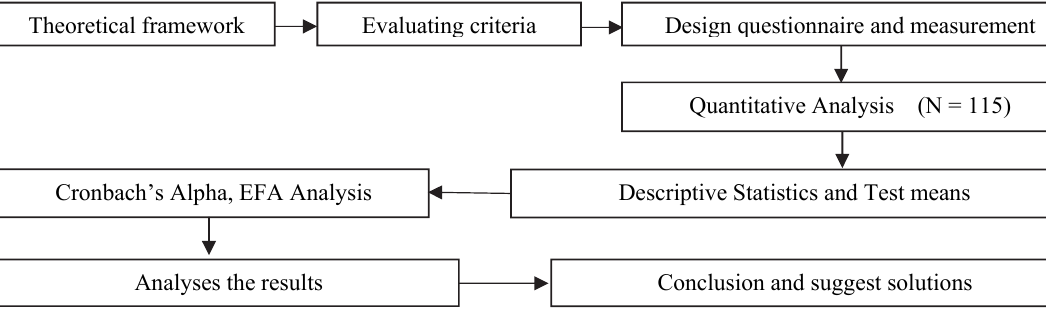
Theoretical framework Evaluating